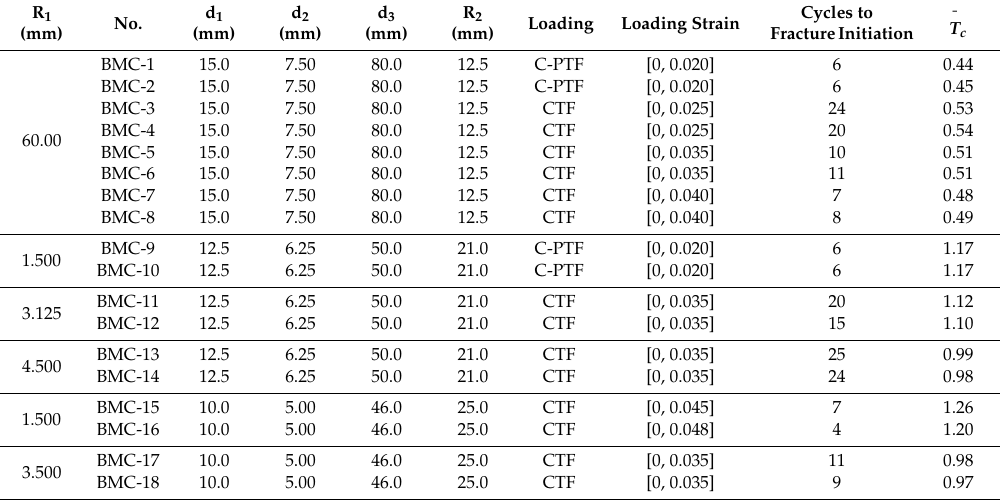
Figure 7. Contour of notched specimens for cyclic tests (unit: mm). Table 4. Dimensions and loading protocols of circular notched specimens.